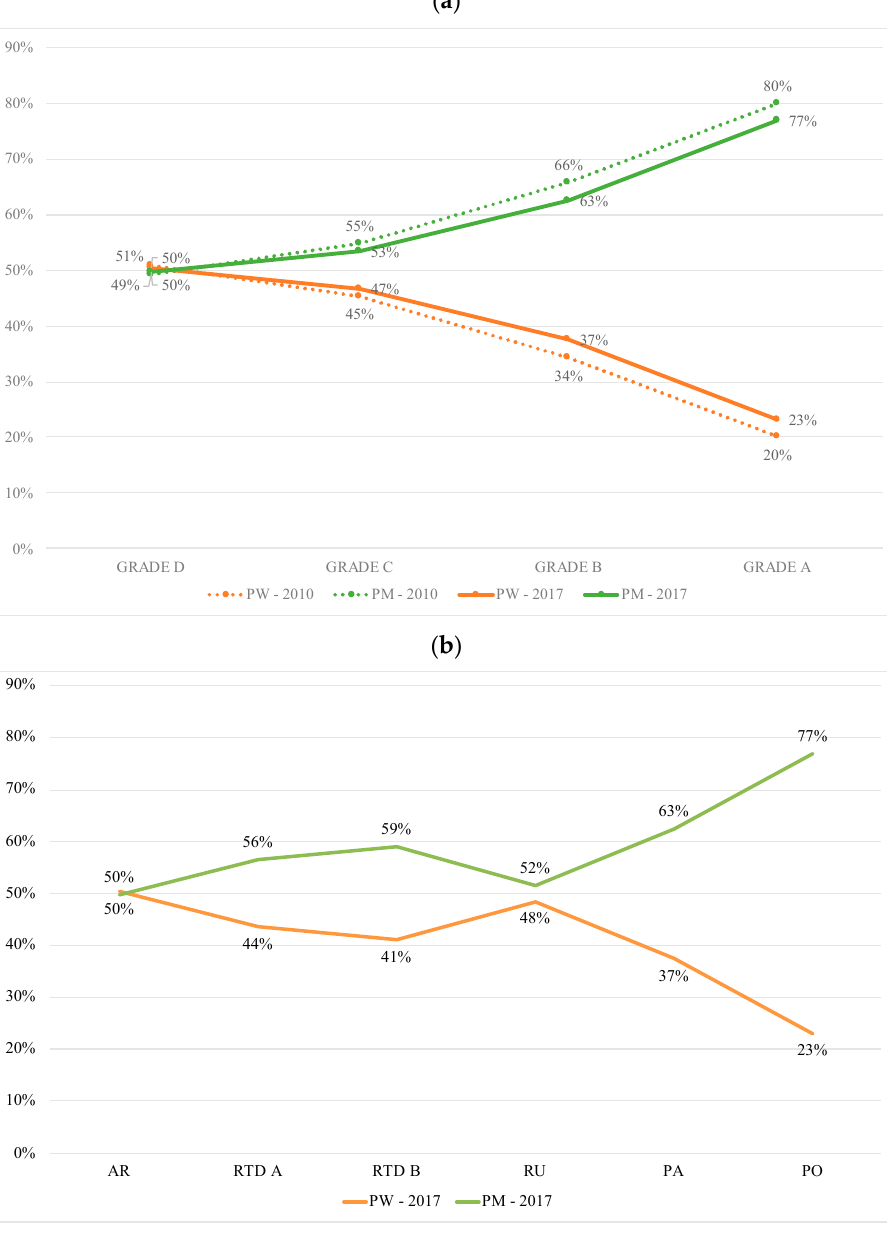
Figure 1. Scissors diagram of academic careers in Italy: ( a ) decoding grades of academic career by the Ministero dell’Istruzione, dell’Università e della Ricerca (MIUR); ( b ) disaggregated data (Picardi 2019).